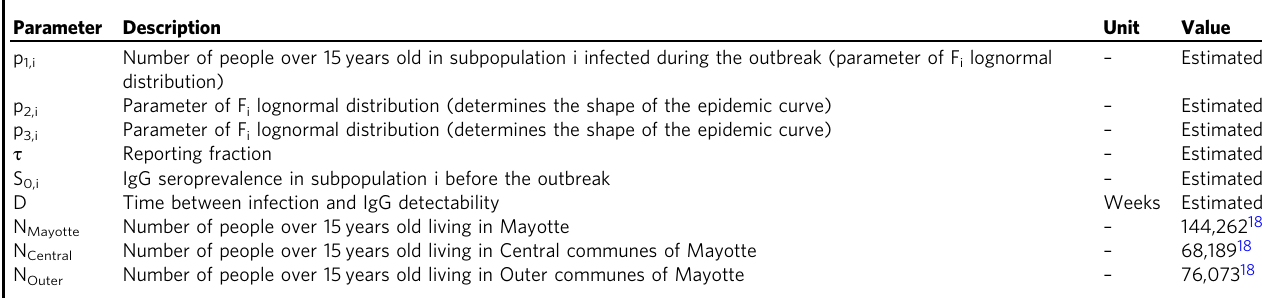
Table 1 Description of model parameters: notation, description, unit and value (estimated from data or extracted from the